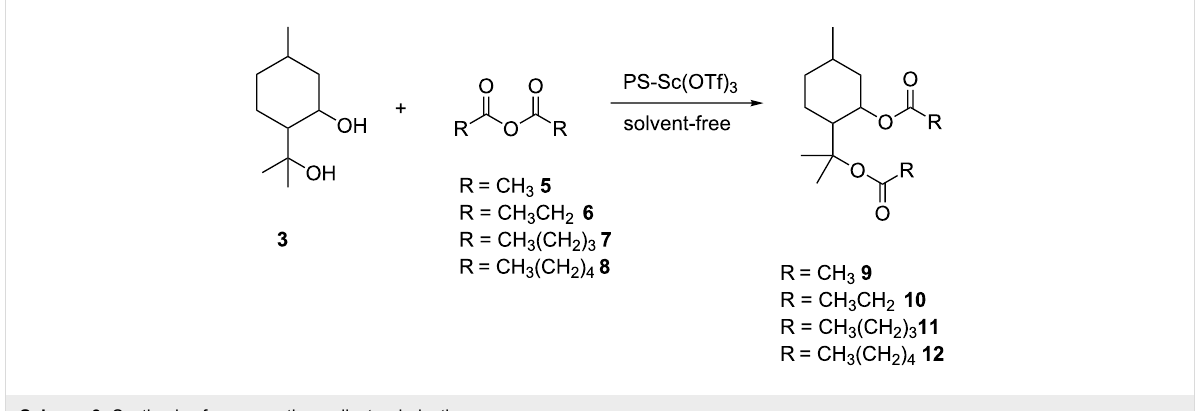
time and reagent molar ratio were studied towards the substrate conversion and product